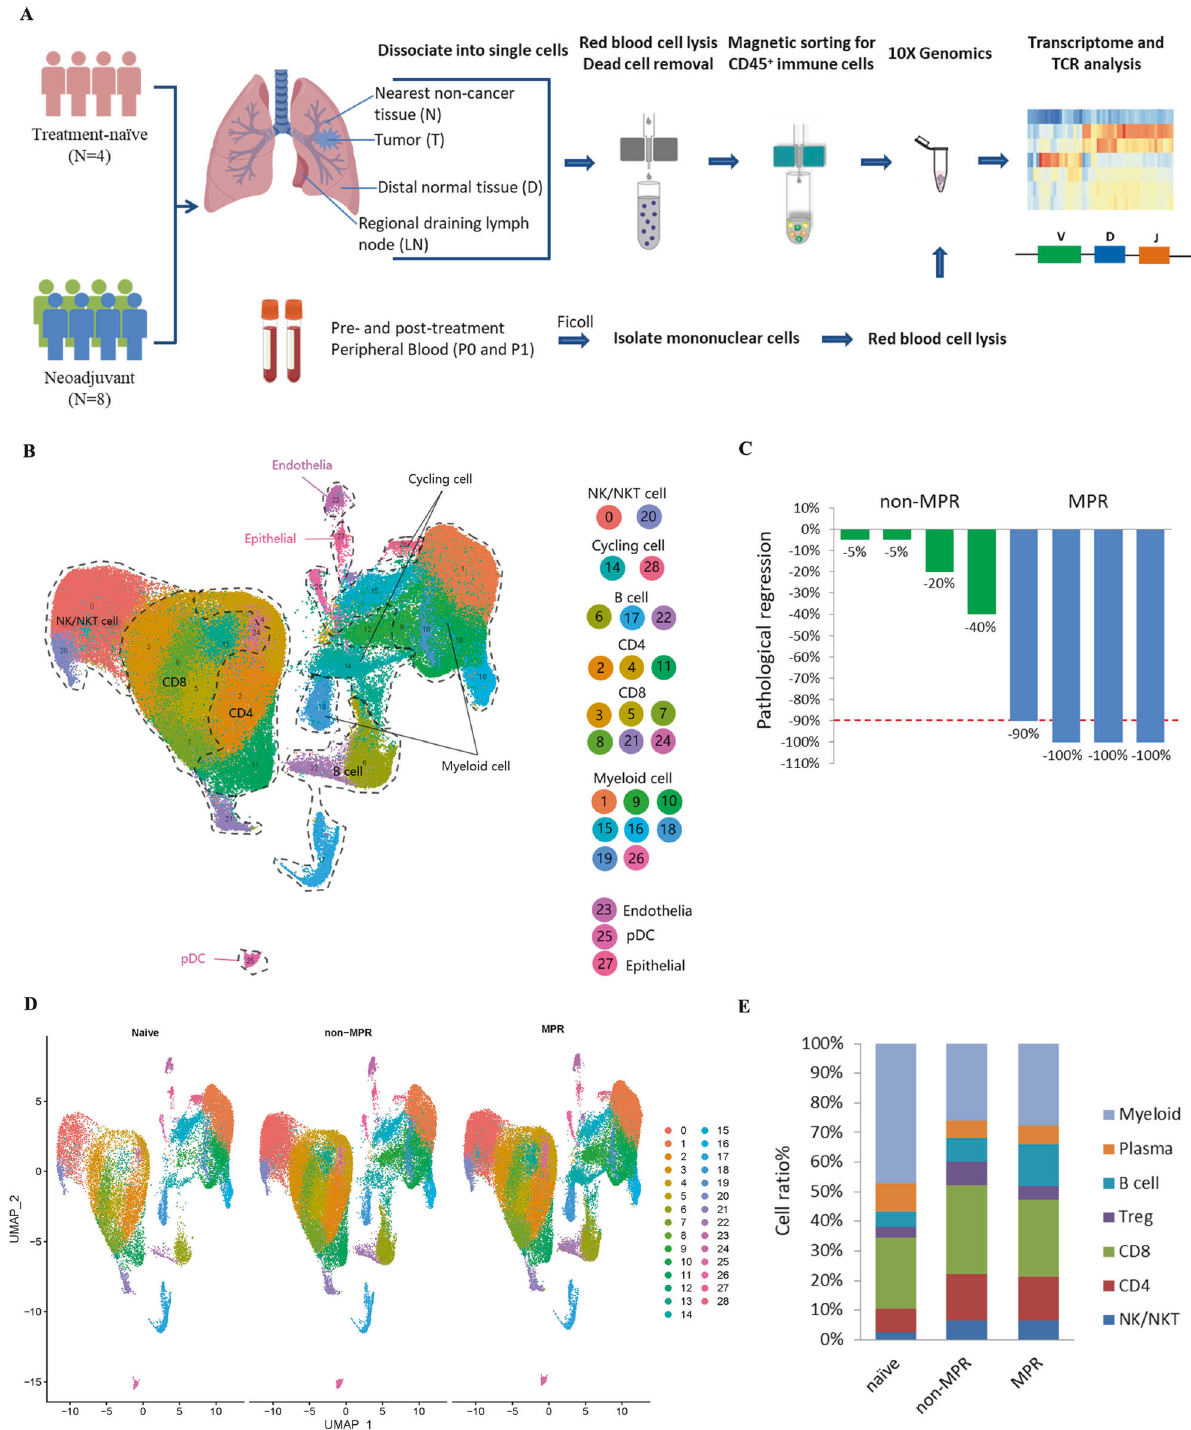
Fig. 1 Clustering and dominant immune cells associated with neoadjuvant response. A Flow chart of the overall study design (Figure created with biorender.com.). CD45 + immune cells derived from tumor tissues (T) and fi ve immune-relevant sites (nearest non-cancer tissues (N), regional draining lymph nodes (LN), distal normal tissues (D), peripheral blood mononuclear cells before and after neoadjuvant therapy (hereafter we called P0 and P1)) were applied to single-cell transcriptome/TCR sequencing. B The UMAP projection of 186,477 cells from 12 patients, showing the formation of 29 main clusters, including two for NK/NKT cells, three for B cells and plasma cells, three for CD4 + T cells, six for CD8 + T cells, eight for myeloid clusters and two cycling cells. Each dot corresponds to one single cell, colored according to the cell cluster. C Neoadjuvant patient categories according to their pathologic response, with four patients in MPR and four patients in non-MPR groups. D UMAP displaying of the immune cell composition in treatment-naive, non-MPR and MPR tumor tissues. E Composites of major immune cell proportions in treatment-naive, non-MPR, and MPR tumor tissues.